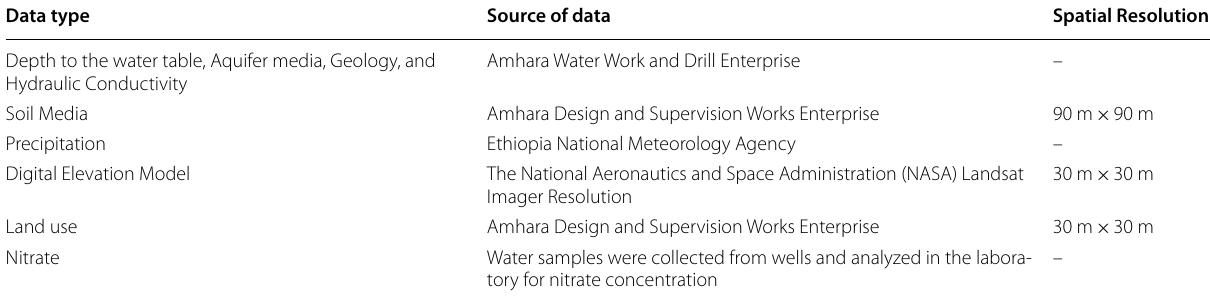
Table 1 Data used in this study and their sources